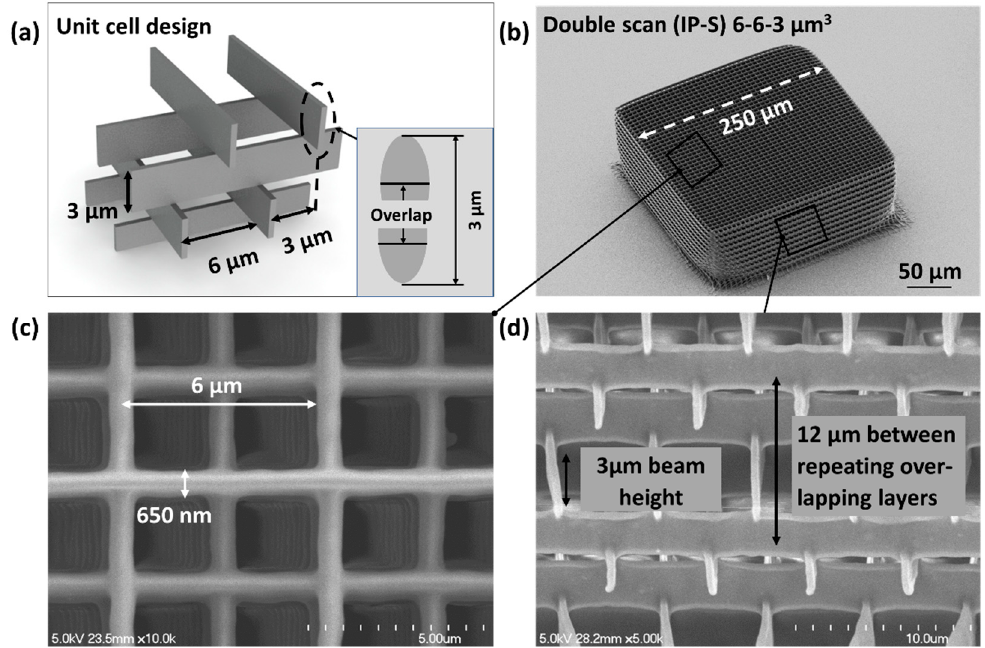
Figure 4. ( a ) The design of a log-pile structure with a 6 × 6 × 3 μ m 3 cell size fabricated using 50% overlapping double scans as described in the text. SEM images of ( b ) the 250 × 250 × 100 μ m 3 foam block fabricated in IP-S resin and in magnified views from ( c ) the top showing the linewidth and horizontal lattice spacing and ( d ) the side indicating the repeating overlap of every fourth layer, i.e., 4 × 3 um = 12 um.